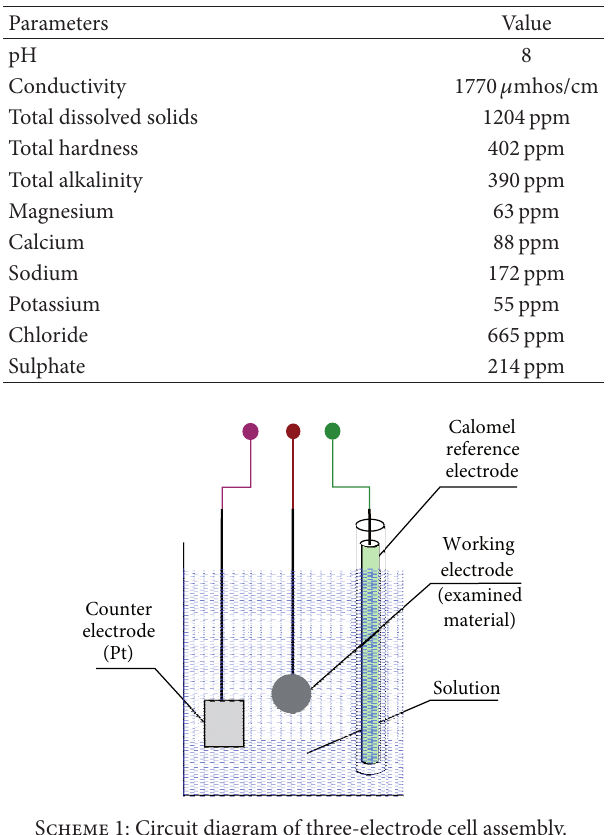
S 1: Circuit diagram of three-electrode cell